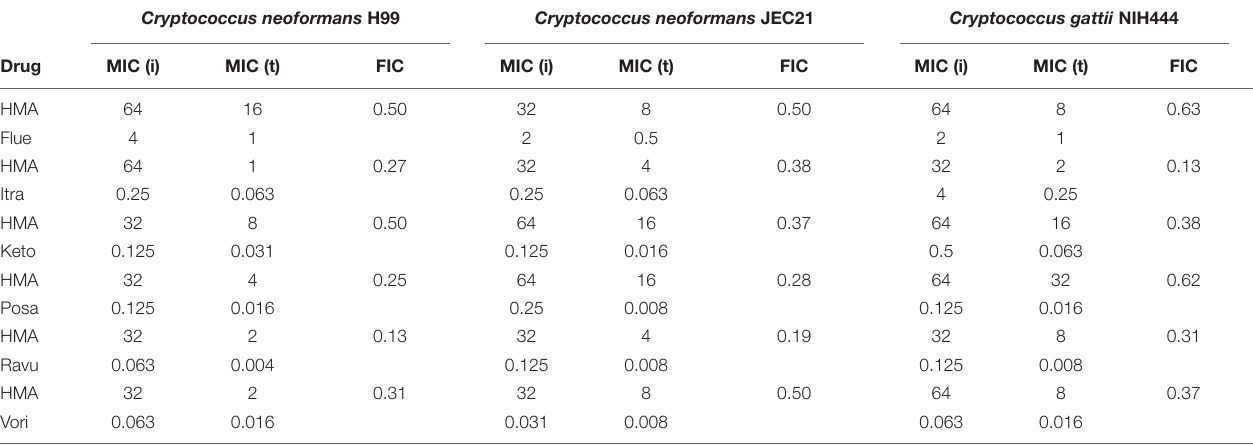
TABLE 2 | Synergy activity of HMA with azole antifungal drugs against strains of Cryptococcus: Cryptococcus neoformans H99, Cryptococcus neoformans JEC21, and Cryptococcus gattii. Cryptococcus neoformans H99 Cryptococcus neoformans JEC21